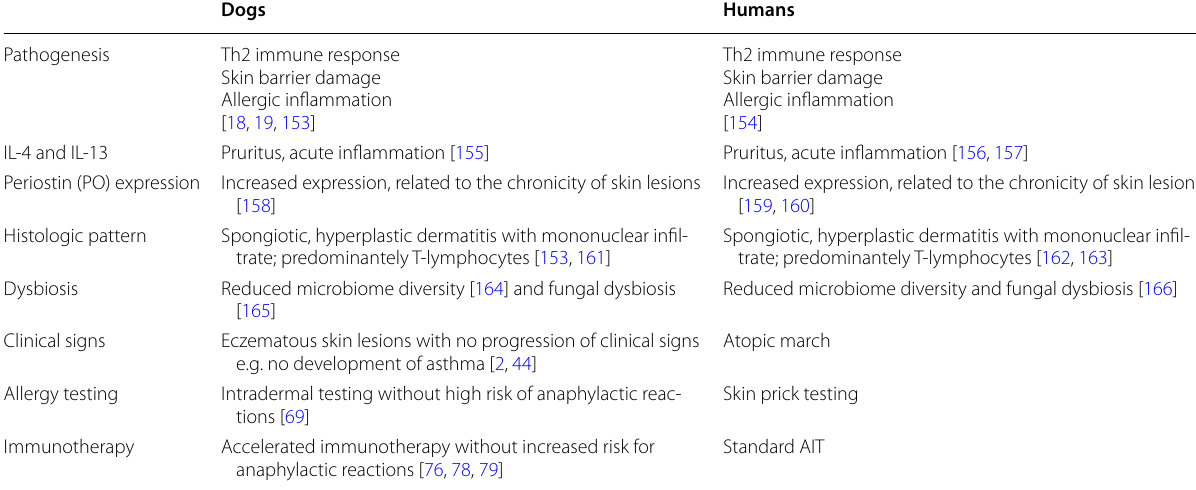
Table 1 Similarities and differences of AD in dogs and humans Dogs